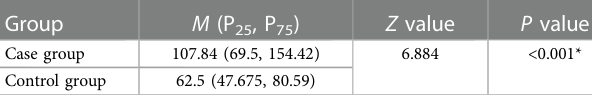
were 48 and 53, respectively ( Table 3 ). Age, risk strati fi cation and PRETEXT stage were signi fi cantly associated with the high NLR and PLR groups ( P < 0.001, respectively). AFP and LDH were signi fi cantly related with the high NLR group ( P = 0.034 and P = 0.026 respectively).